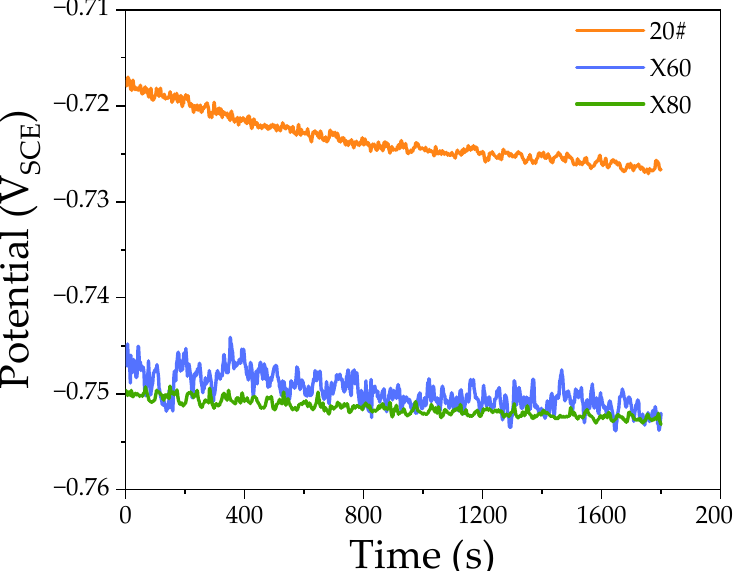
mpy. Figure 7 shows the morphology of the samples after the removal of the corrosion